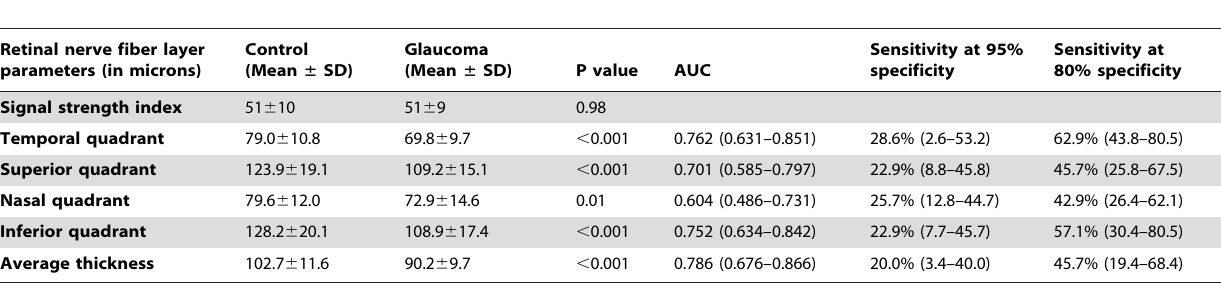
Table 2. Mean values of SDOCT retinal nerve fiber layer thickness parameters in glaucoma and control eyes with areas under the receiver operating characteristic curves and sensitivities at fixed specificities.